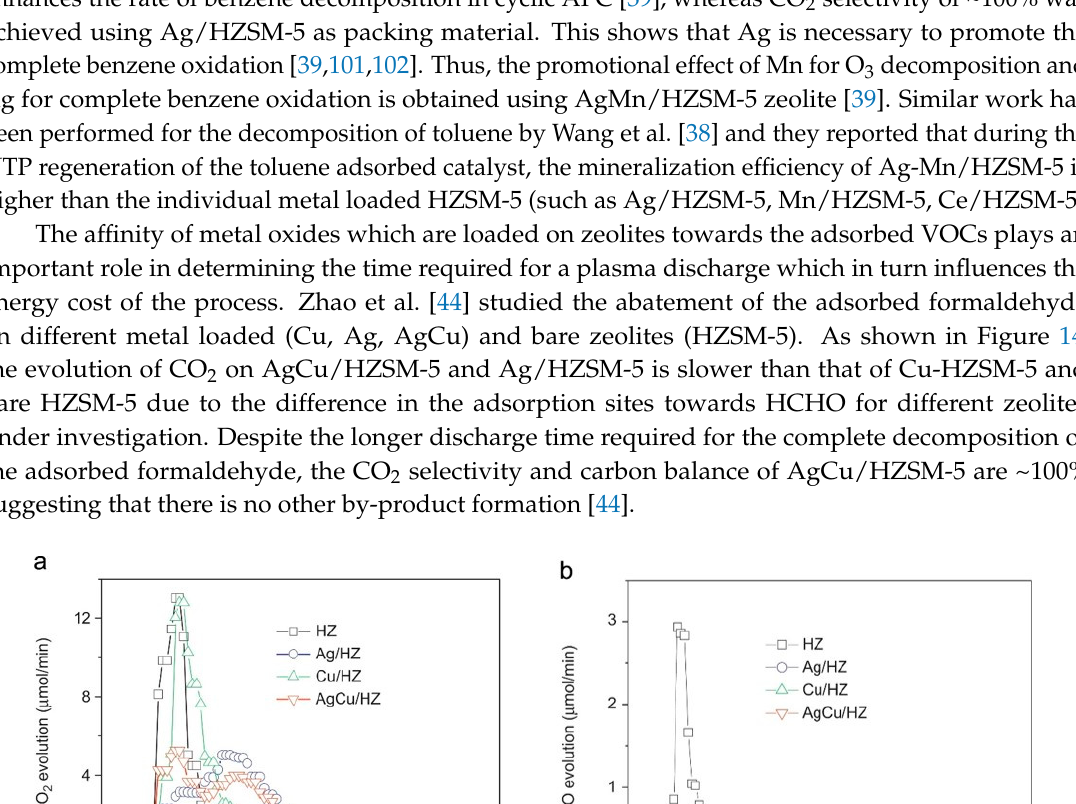
= 2.3 W). discharge